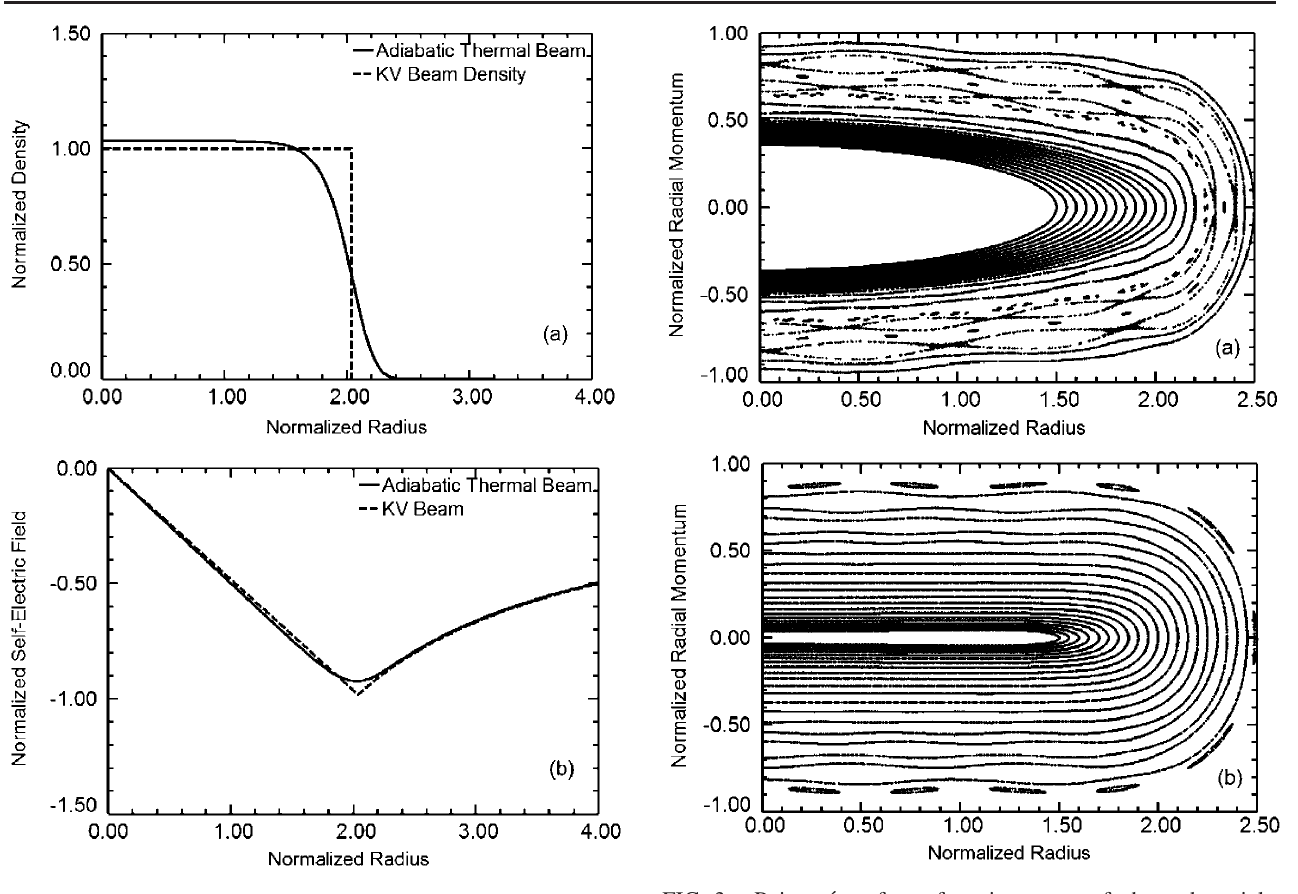
.FIG. 2. Plots of (a) normalized density n b =n KV ð 0 ; 0 Þ and (b) normalized radial self-electric field S 3 = 2 KE r = 4 " 1 = 2 th qN b ver- ffiffiffiffiffiffiffiffiffiffiffiffi p 4 " S sus normalized radius r= in the KV-type beam equilib- th rium (dashed curve) and the adiabatic thermal beam equilibrium (solid curve) at s ¼ 0 for the same choice of system parameters as in Fig. 1. Here, n KV ð 0 ; 0 Þ is the density of the KV-type beam equilibrium at s ¼ 0 and r ¼ 0